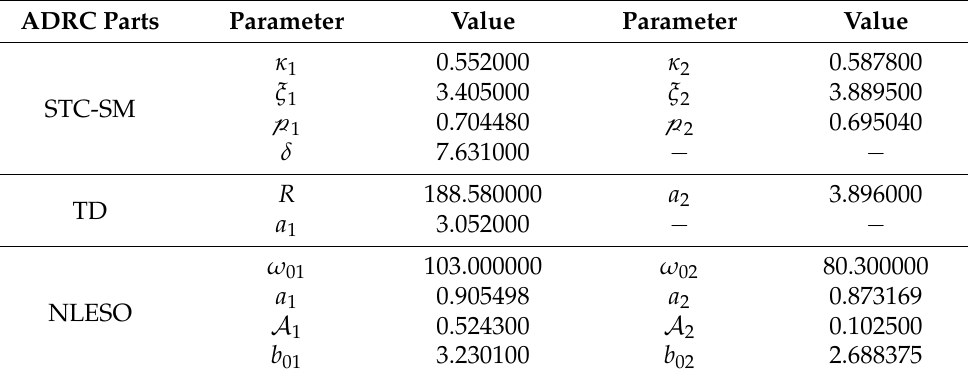
Table 10. STC-ADRC parameters (1st MADRC scheme).